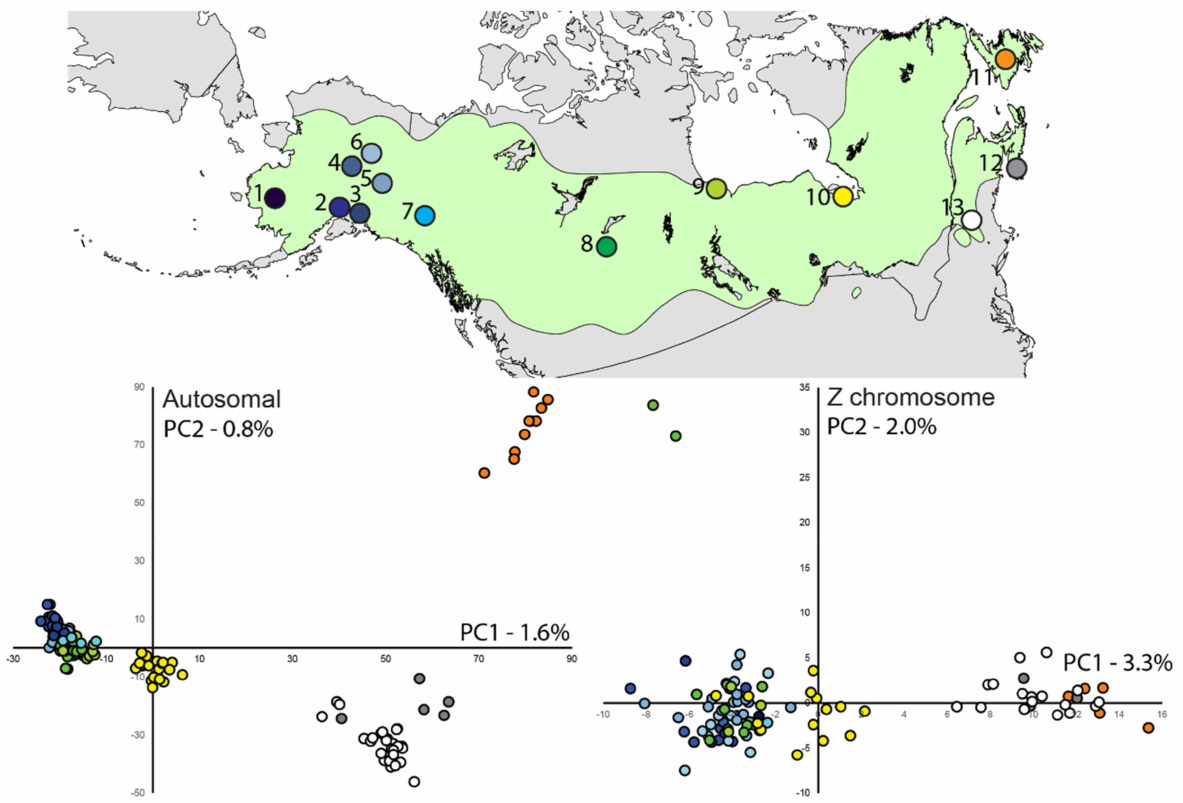
Figure 1. Nesting distribution of rusty blackbirds with sampling locations color-coded and numbered (see Table 1). We note that location 13 (white circle) includes sample locations in Vermont and New Hampshire, USA, and location 12 (grey circle) includes both Nova Scotia and New Brunswick, Canada. The scatter plots are of the first two principal components plotted for haplotypic data, with the proportion of variance explained, from 6205 autosomal and 231 Z-linked loci (males only, because principal components analysis (PCA) does not accommodate